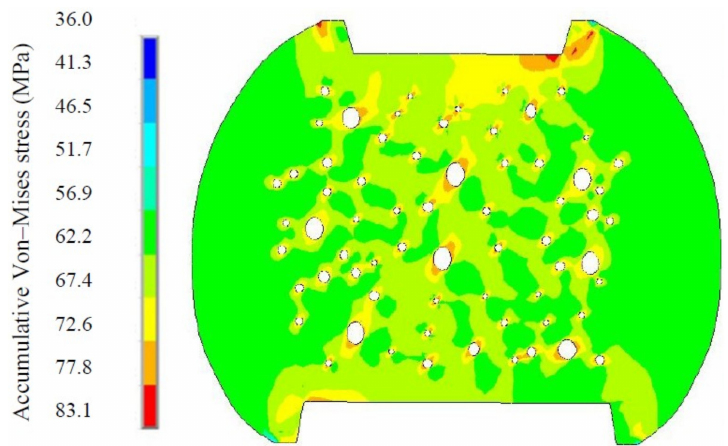
Figure 5. An accumulative Von-Mises stress contour of the corner micro-joint with dispersed Ag 3 Sn particles in different size after eight TS cycles.